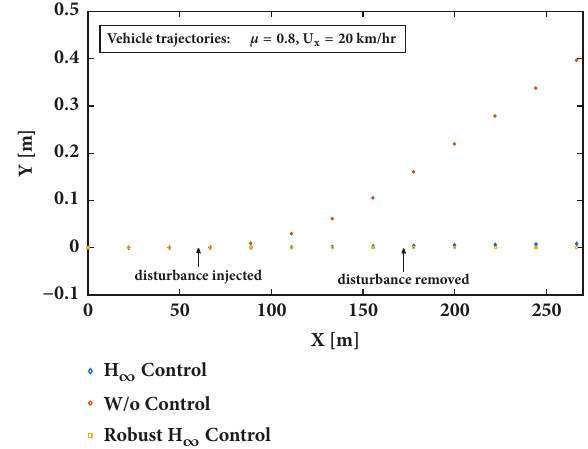
Figure 4: Δ𝑤 : 𝜇 = 0 .2; vehicle speed: 120km / hr.